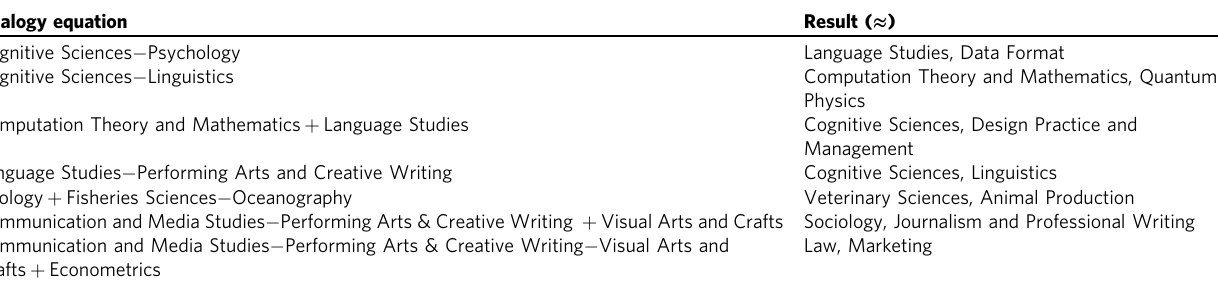
Table 3 Top two most similar vectors to the offset created by additions and subtractions.